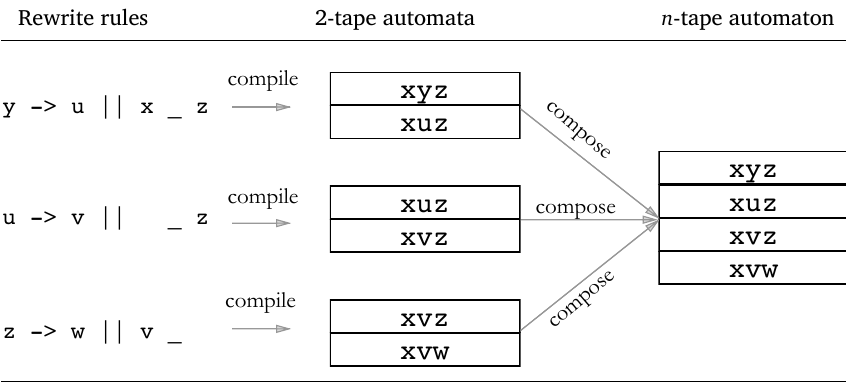
Figure 2: Workflow for converting rewrite rule specifications to transducers, then 2-tape automata, then n -tape